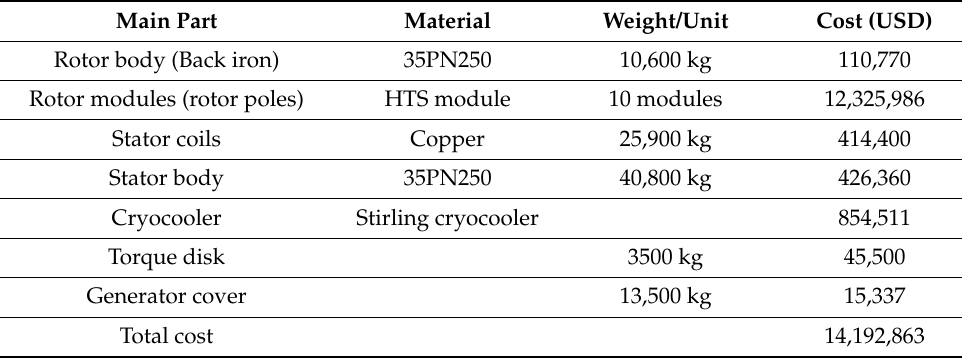
Table 3. Cost for the 10 MW class